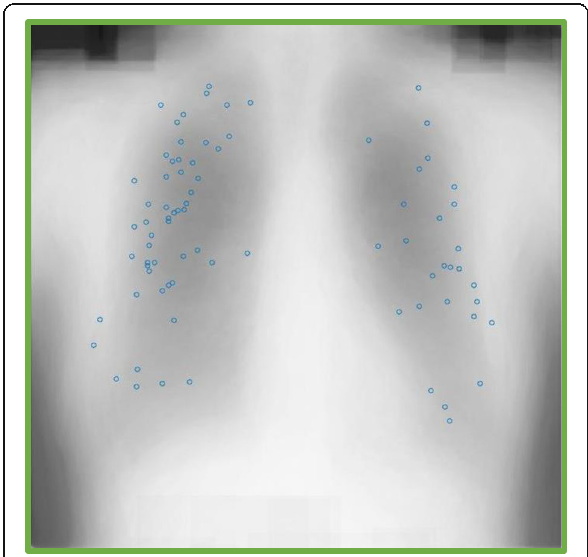
Fig. 7 Tumor locations against an average chest radiographic image from the stimuli used in the current study. Each blue dot represents the center location of a tumor from one